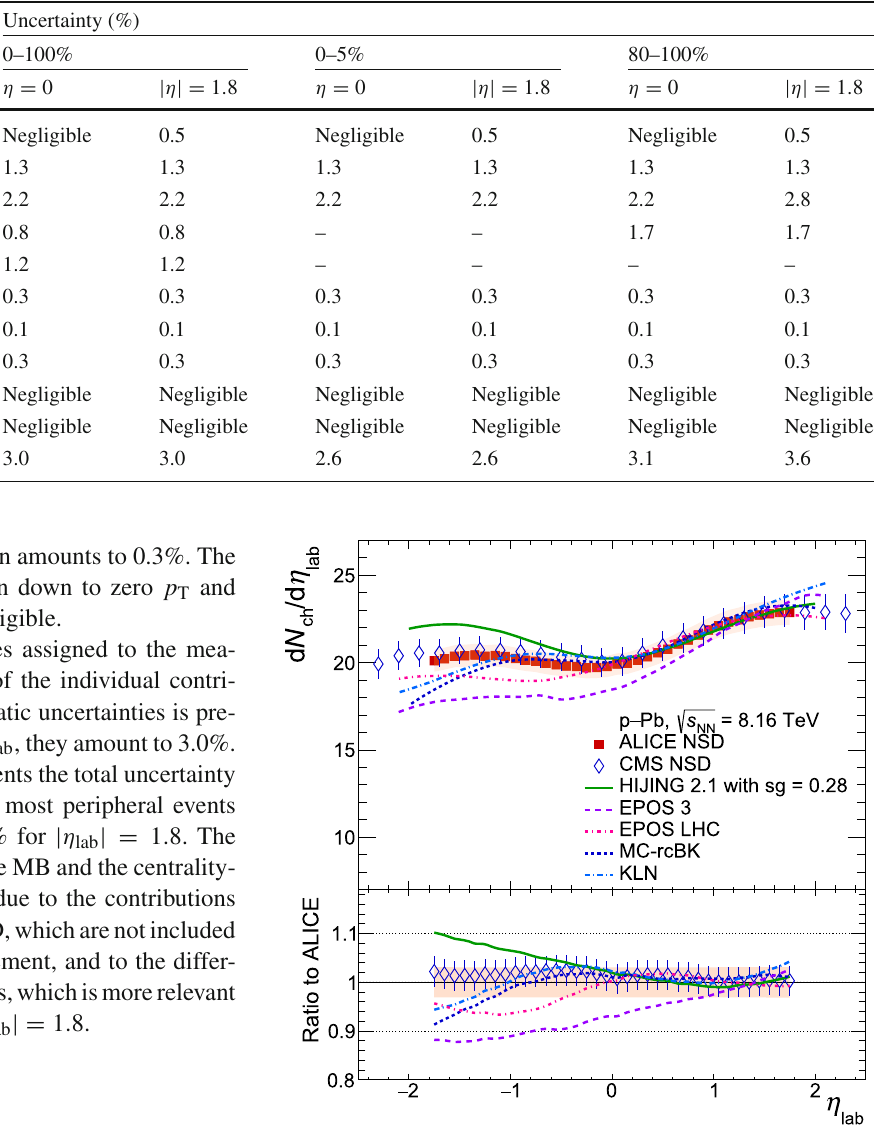
√ = 8 . 16 TeV in s NN